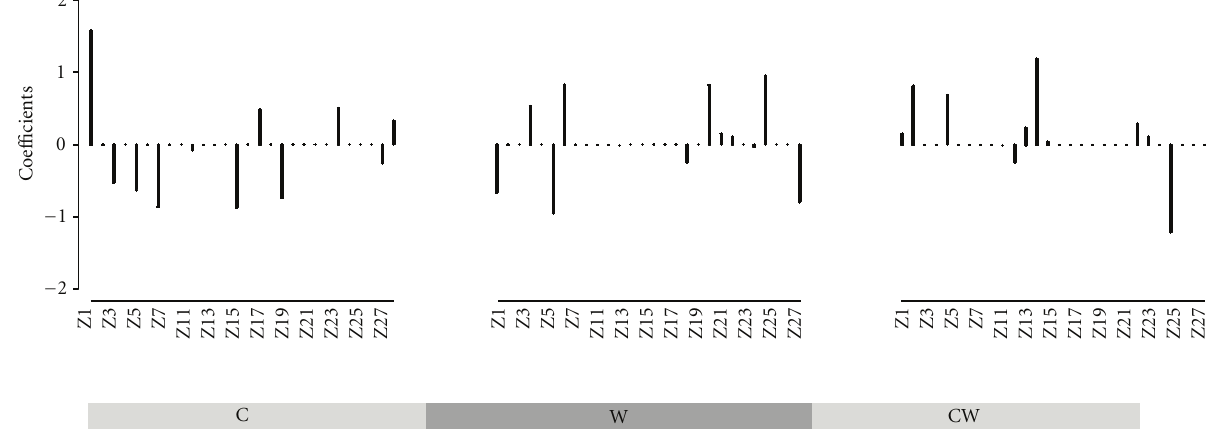
Figure 1: Estimated e ff ects of trait-environment interaction using Type-II